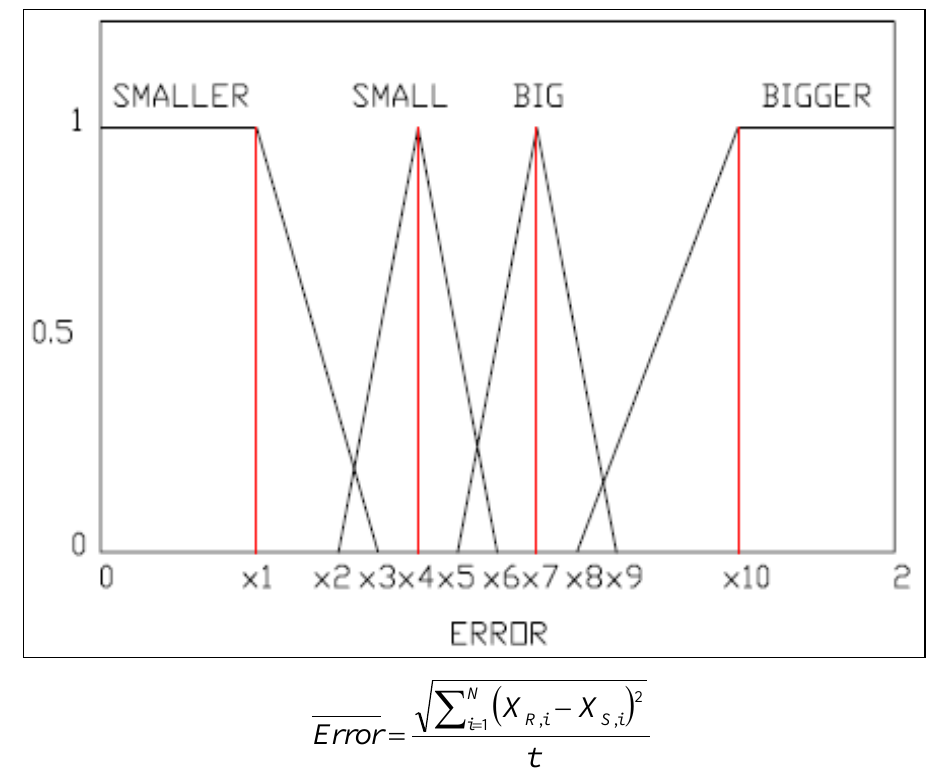
Figure 15. Four membership functions used in fuzzy